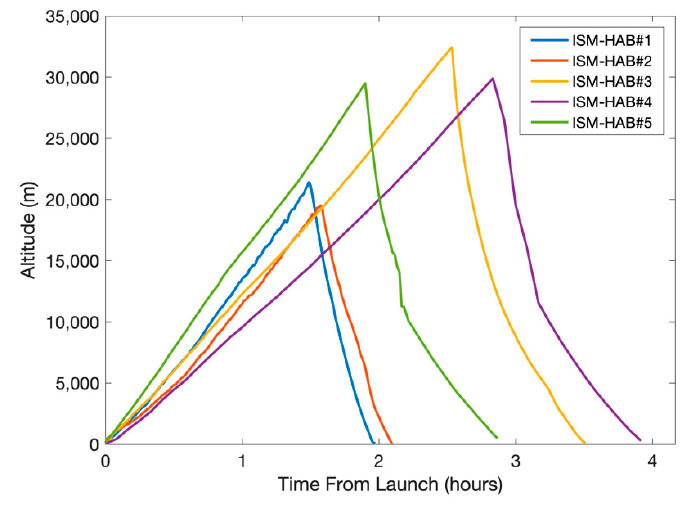
Figure 14. Altitude profiles as a function of time.